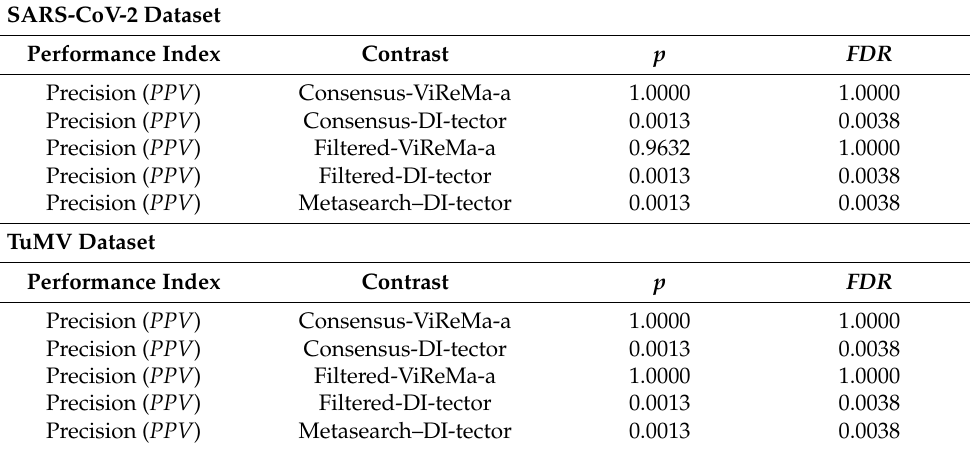
Table 5. Pairwise comparisons (Wilcoxon signed rank test for paired samples) for precision in both sets of synthetic samples. The one-tailed contrast is defined in the contrast column. The p -value was corrected with Benjamini-Hochberg FDR